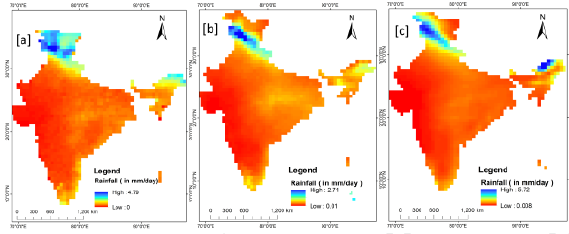
Figure 3. Seasonal rainfall during DJF in [a] IMD Product, [b] APHRODITE Product and [c] Era-Interim Product.